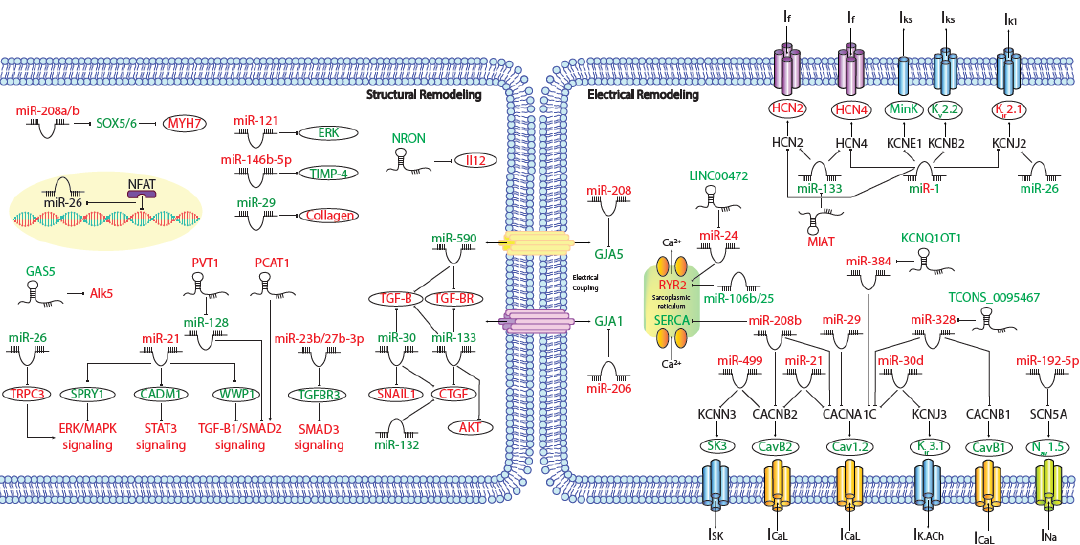
Figure 2. Schematic representation of the activated molecular program in atrial fibrillation. miRNAs and lncRNAs networks controlling structural and electrical remodelling in AF. (Red and green labels correspond with induced or repressed molecules in AF, respectively).